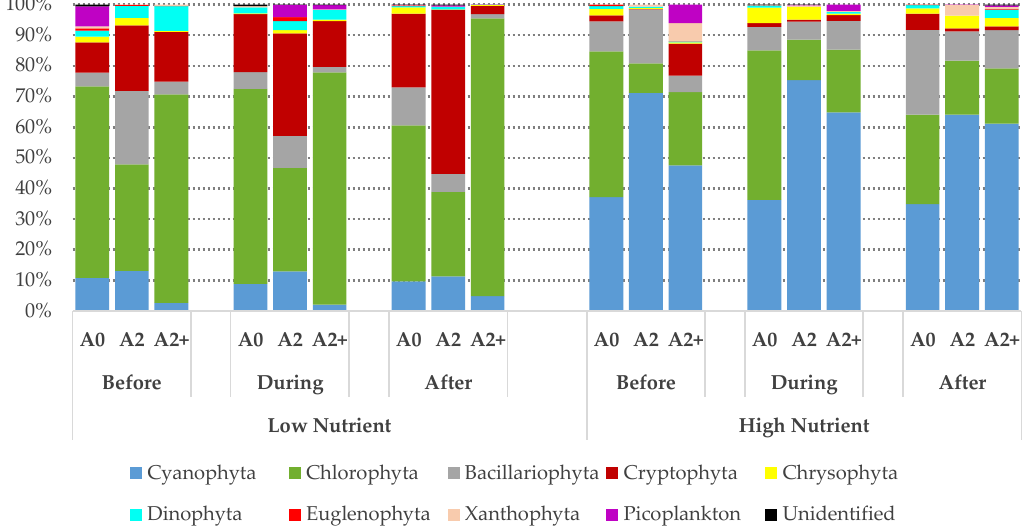
Figure 2. Percentage biomass contributions of phytoplankton taxa for each treatment and period.